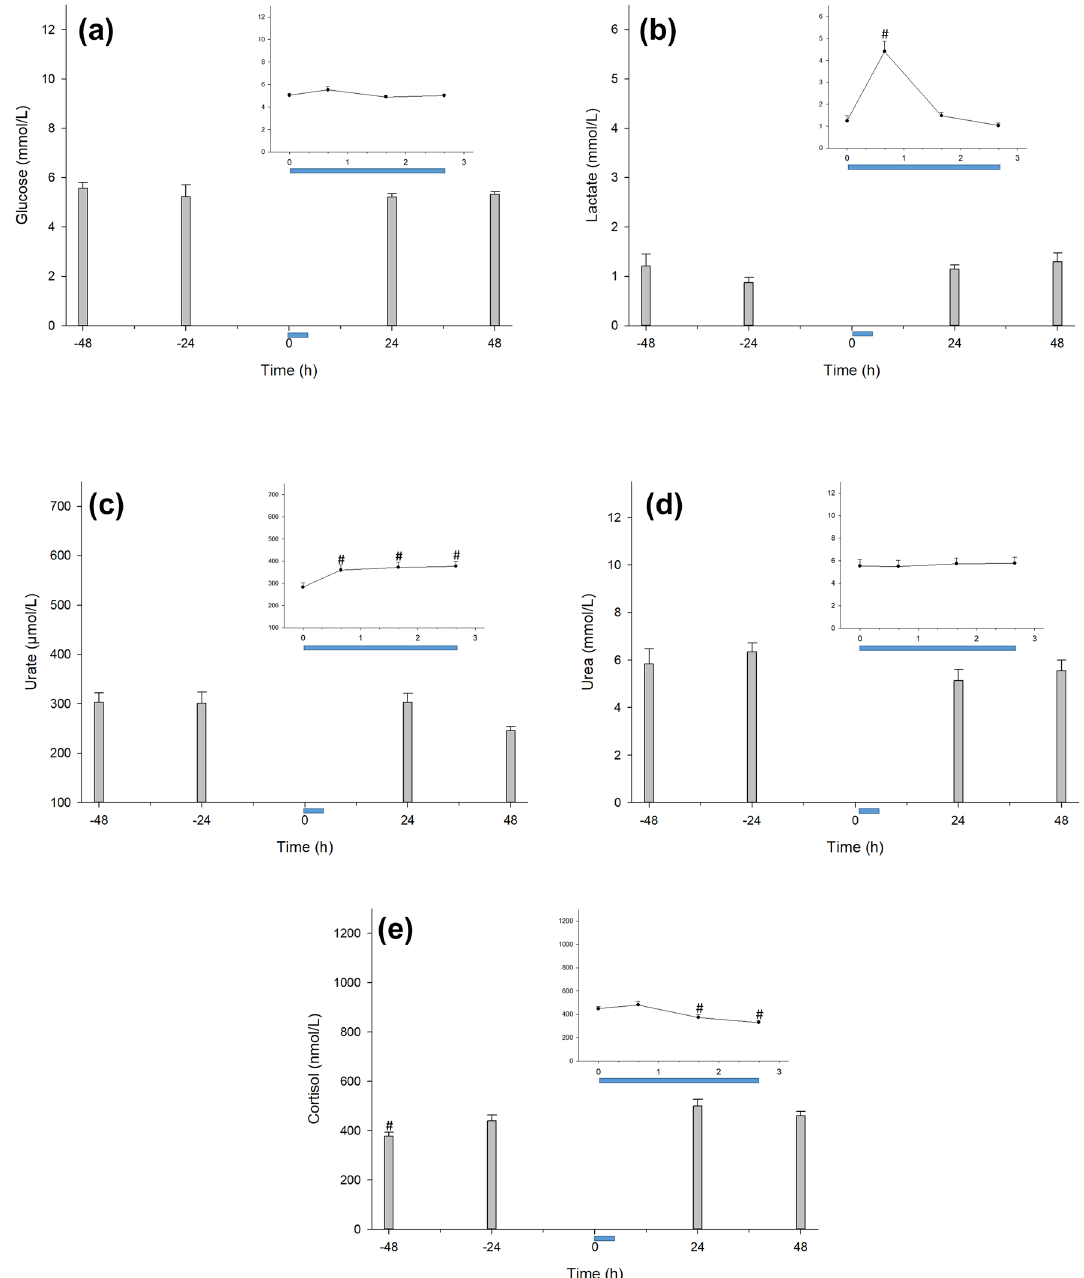
Figure 3. The CCombat protocol promoted an increase in both serum lactate and urate without changing glycemia or uremia. ( a ) Glucose; ( b ) lactate #Pre vs . Post: p < .001; effect size = 1.9; statistical power = 0.99; ( c ) urate #Pre vs. Post: p = .017; effect size = 0.9; statistical power = 0.92; #Pre vs. + 60 min: p = .004; effect size = 1.0; statistical power = 0.97; #Pre vs. + 120 min: p = .005; effect size = 1.1; statistical power = 0.98; ( d ) urea and ( e ) cortisol #Pre vs . − 48 h: p = .010; effect size = 1.0; statistical power = 0.94; #Pre vs . + 60 min: p = .031; effect size = 0.8; statistical power = 0.83; #Pre vs . + 120 min: p < .001; effect size = 1.5; statistical power = 0.99. The blue bar represents the CCombat protocol in scale in both graphs. AVG ±